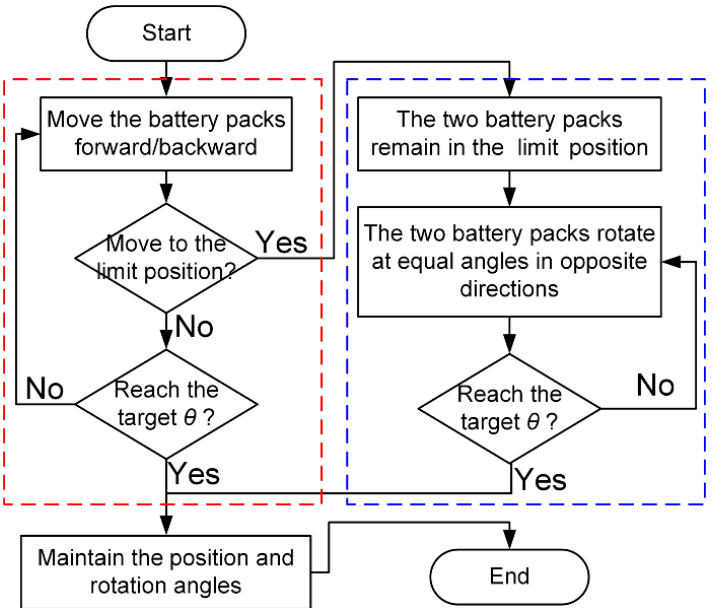
Figure 2. The regulation process of θ by DARM. The red dashed box shows the legacy pattern, while the blue dashed box shows the DARM pattern.